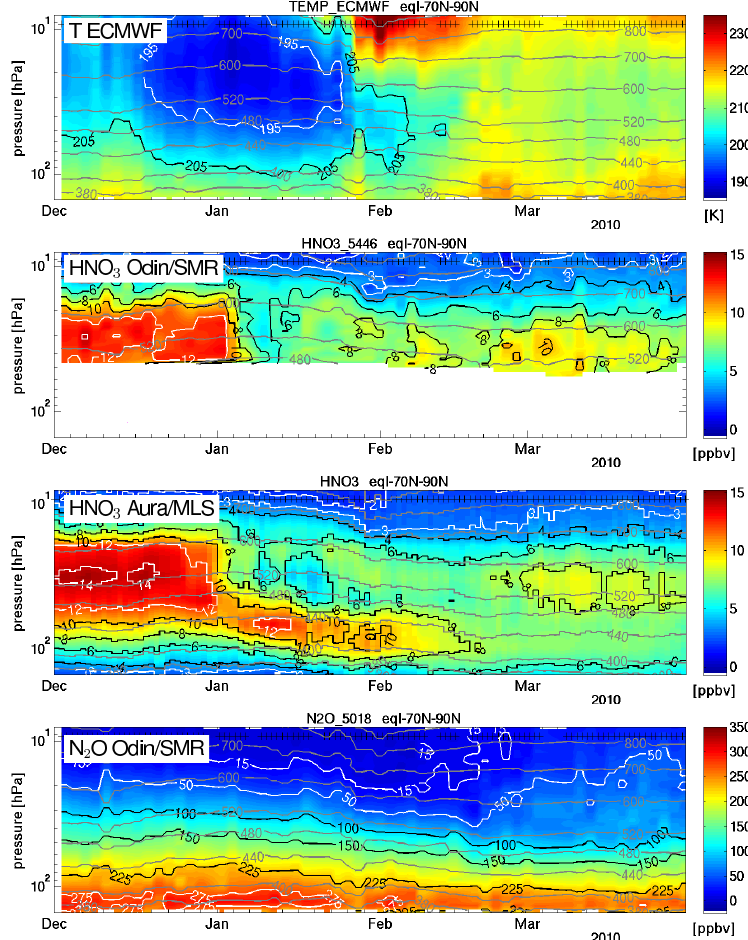
Fig. 3. Temporal evolution of temperature, HNO 3 and N 2 O at high northern equivalent latitudes (70–90 ◦ N) as function of pressure. Top: daily mean temperatures derived from ECMWF data at the position of the Odin/SMR measurements. Second and third row: daily mean HNO 3 from Odin/SMR and from Aura/MLS observations, respectively. Bottom: daily mean N 2 O from Odin/SMR. Potential temperature levels are given as grey lines. Crosses at the top of the plots indicate observation days.